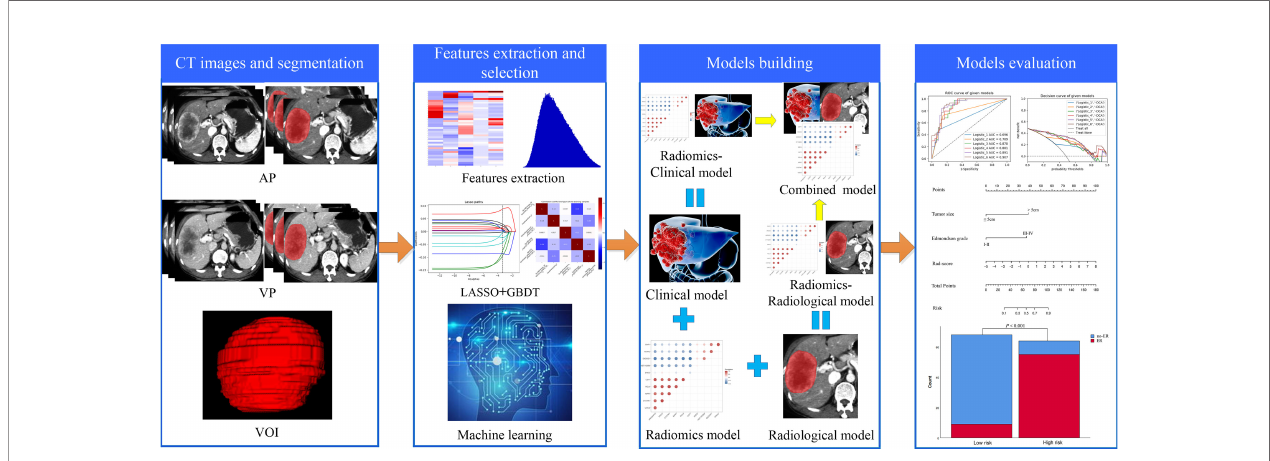
FIGURE 2 | Schematic diagram of construction and evaluation of